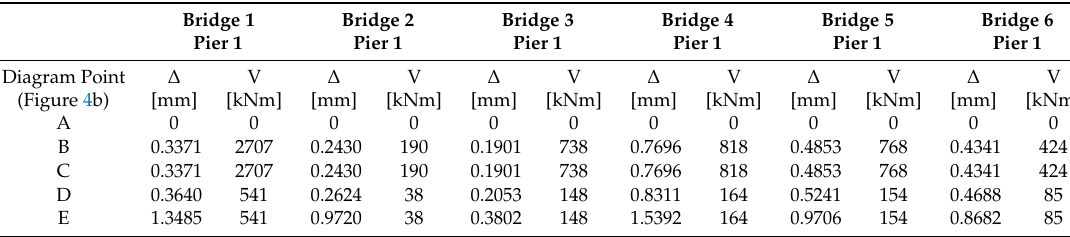
Table 2. Idealized shear-displacement plastic hinge laws (Z